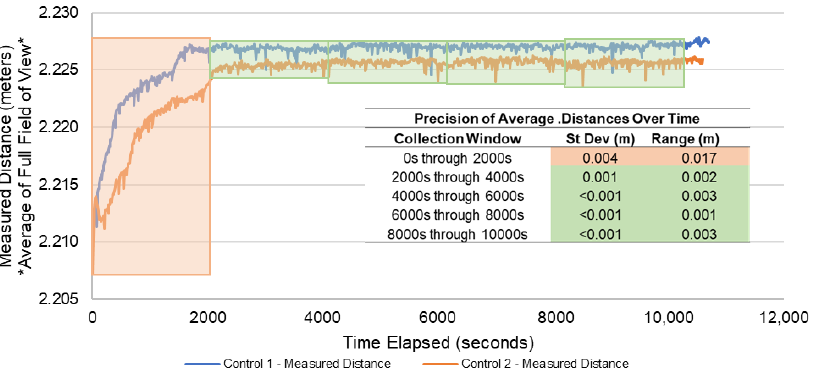
Figure 25. Average measured distance of the Livox ® Mid–40’s field of view over time during indoor experiments.